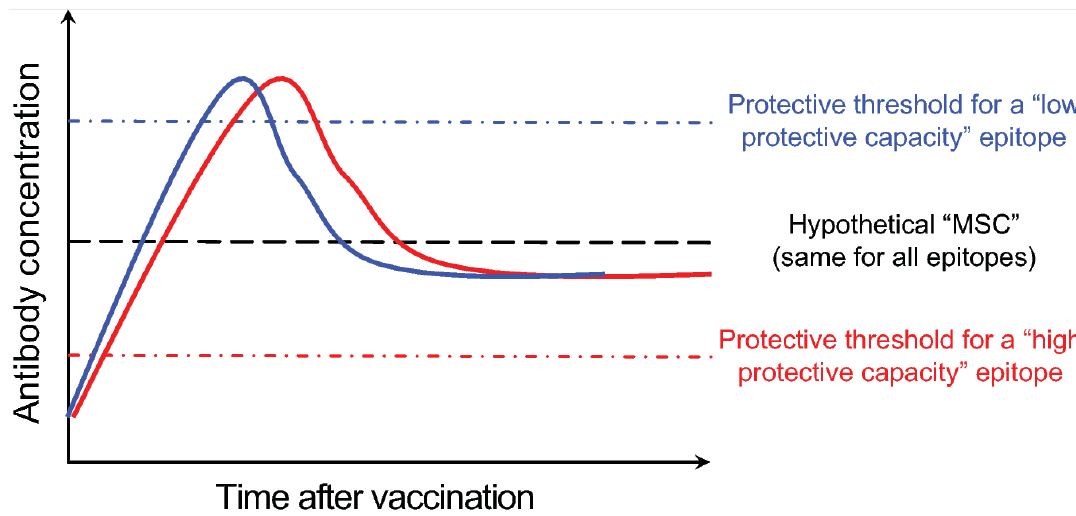
Figure 3. Proposed model for high- and low-protective capacity B cell epitopes. This is a hypothetical plot of serum anti-influenza antibody concentration vs. time after influenza vaccination. Shown are examples of the kinetics of antibody responses directed against two distinct epitopes (blue and red solid lines). Responses against the “red” epitope are protective due to its relatively low protective threshold and vice versa for responses directed against the “blue” epitope. The black dotted line in the middle represents a hypothetical “maximal sustainable concentration” of serum antibodies against any epitope.